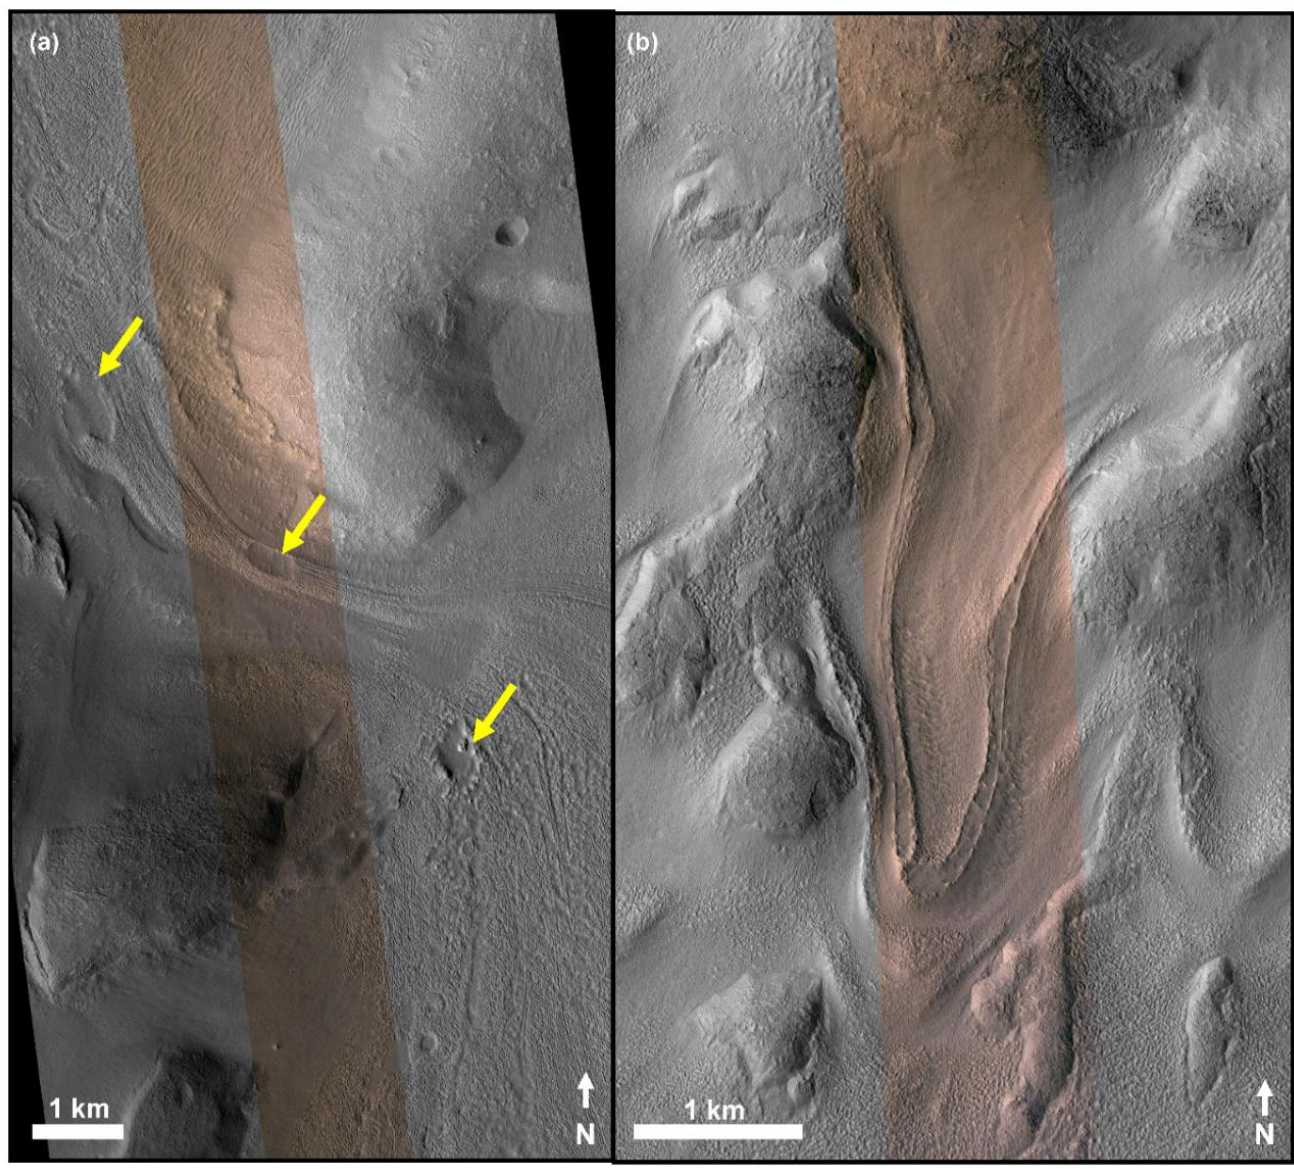
Figure 2. Examples of lobate debris aprons (LDA) in Deuteronilus Mensae (mid-latitude, Mars) and a tongue-shaped flow feature in eastern Hellas Planitia (mid-latitude, Mars): ( a ) Deuteronilus Mensae LDA. Feature shows possible sublimation pits (yellow arrows). HiRISE/MRO image ESP_028721_2225_MIRB; ( b ) tongue-shaped lobate flow feature along an interior crater wall with a length approximately 5 km, width of 1 km. Feature portrays a double inner ridge and raised outer margin and surface is generally devoid of impact craters. HiRISE/MRO image PSP_003243_1415_MIRB. Image credit: